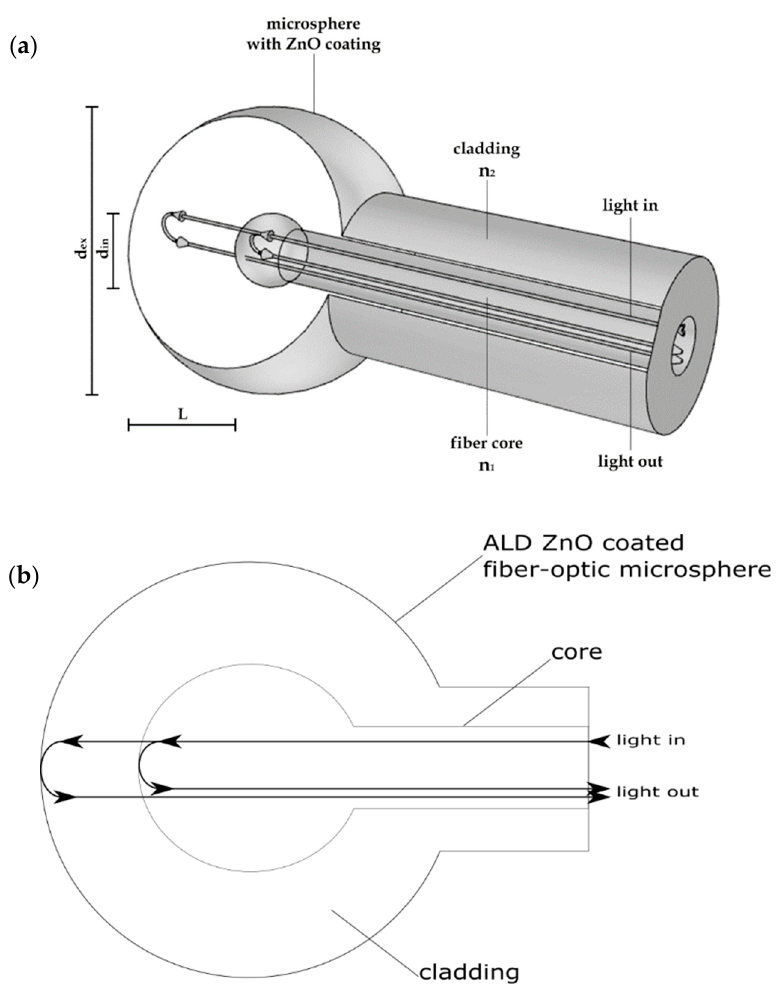
Figure 1. Principle of operation of the microsphere-based sensor with ZnO Atomic Layer Deposition (ALD) coating for temperature measurement: ( a ) schematic representation of a sensor, ( b ) cross-section of the sensor head. Sensors 2020 , 20 , x FOR PEER REVIEW